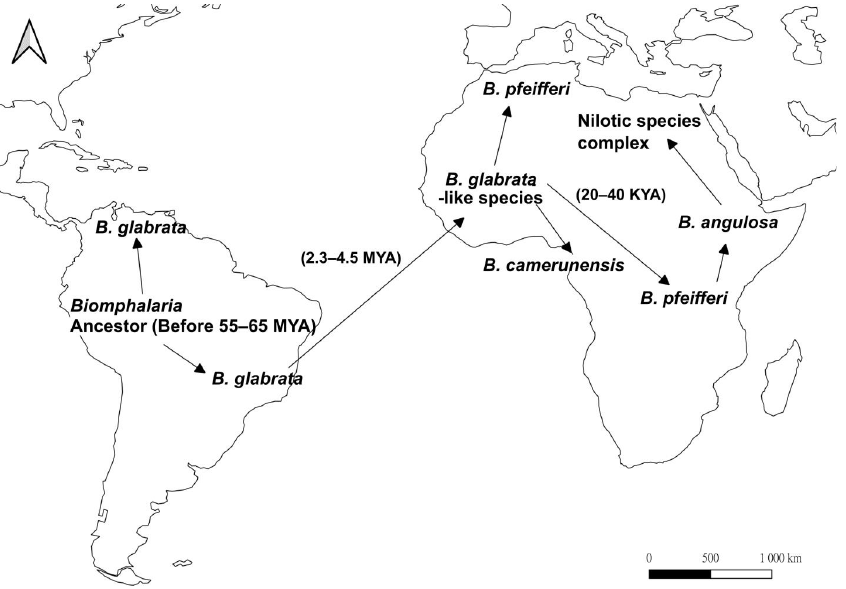
Figure 2. Map showing the proposed evolutionary history of the snail genus, Biomphalaria based on the American origin hypothesis (after [46,51]). Arrows represent proposed dispersal direction. The ancestor of Biomphalaria existed in South America from 55 to 65 million years ago (mya), and later diverged into more than 20 species. B. glabrata -like species underwent trans-Atlantic dispersal in 2.3 – 4.5 mya, separating into B. camerunensis and B. pfeifferi in West Africa. B. pfeifferi colonized East Africa in approximately 20 – 40 kya, which further diverged into B. angulosa and subsequently the Nilotic species complex.